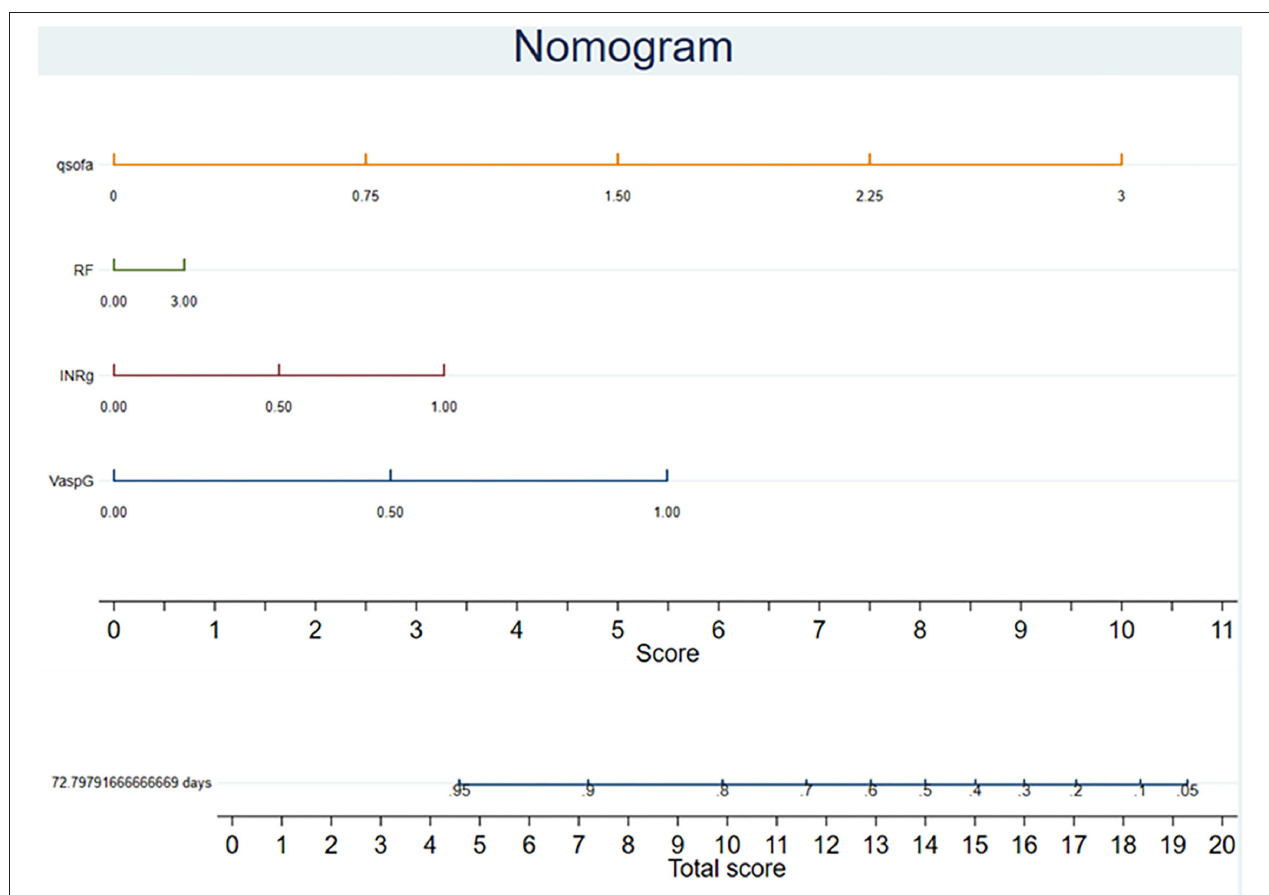
FIGURE 3 | Top features were selected using multivariate Cox-LASSO regression analysis and the corresponding variable importance score. The X-axis indicates the importance score, which is the relative number of a variable that is used to distribute the data, the Y-axis indicates the top-weighted variables. qSOFA (orange line): quick sequential organ failure assessment; RF (green line): impaired severity of pulmonary function (defined as PaO 2 /FiO 2 [PF]) > 300 mmHg, 200 mmHg < PF ≤ 300 mmHg, 100 mmHg < PF ≤ 200 mmHg, PF ≤ 100 mmHg). INRg (purple line): INR > 1.5; VaspG (blue line): use of vasopressor. LASSO, least absolute shrinkage and selection operator; CRRT, continuous renal replacement therapy; qSOFA, quick sequential organ failure assessment; INR, international normalized